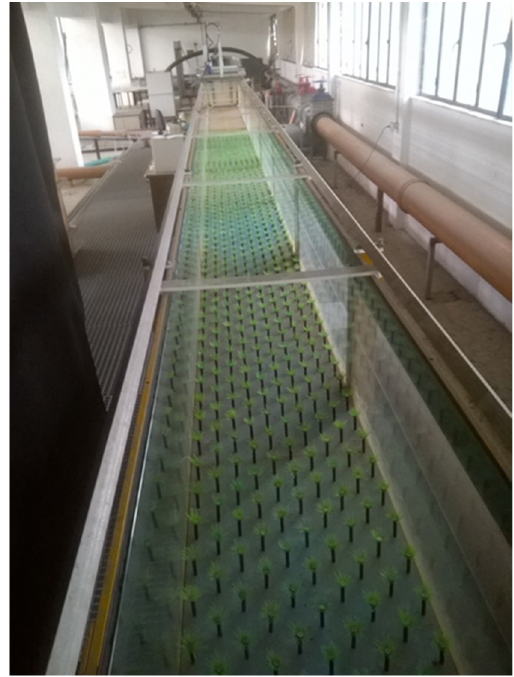
Figure 1. General view of the experimental setup.